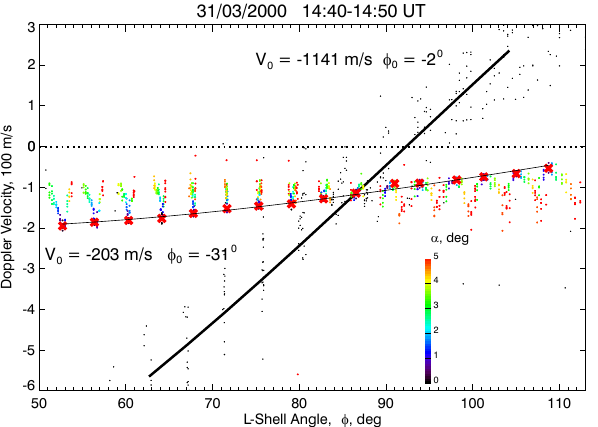
Fig. 3. Scatter plot of the Doppler velocity versus L -shell angle φ for 31 March 2000, 14:40–14:50 UT. The points correspond- ing to E-region scatter are color coded in aspect angle α , as in- dicated in the bottom right part of the diagram. The red crosses are maxima/minima of the averaged velocity along radar beams, as described in the text. The F-region velocities are shown by black points. The solid thin (thick) line represents the best fit, V 0 cos (φ + φ 0 ) , to red crosses (all black points).